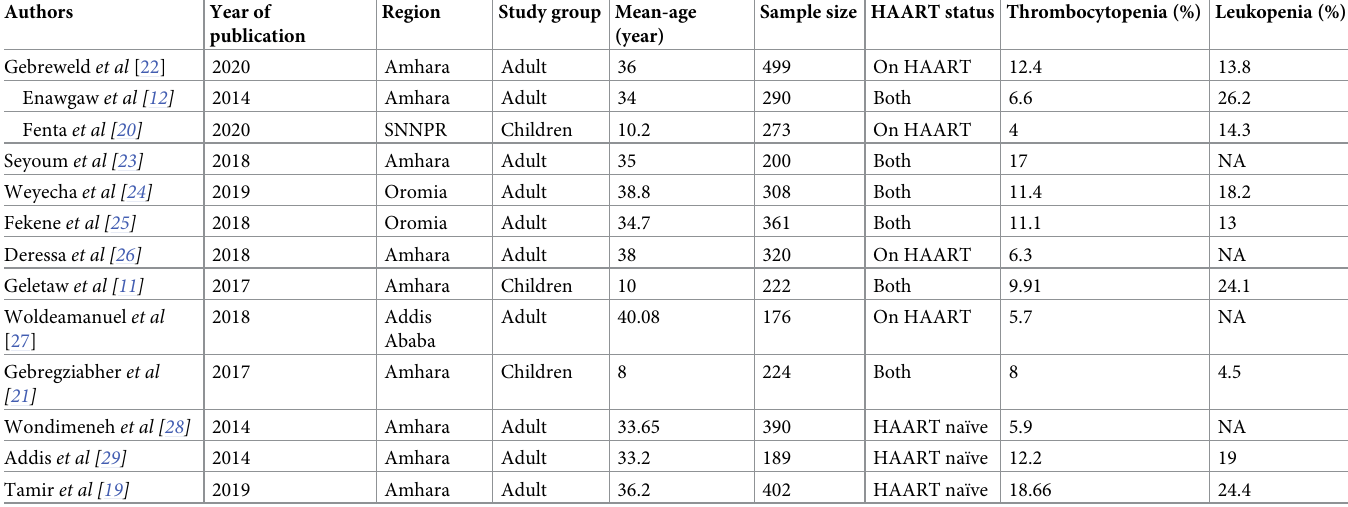
Thrombocytopenia by HAART status. In this systematic review and meta-analysis, ten and nine studies assessed the magnitude of thrombocytopenia in HIV/AIDS patients who are taking HAART and who are HAART na ï ve, respectively. The prevalence of thrombocytopenia among HAART naive participants ranges from 5.9% (95%CI; 3.56–8.24%) to 26% (95% CI;17.4–34.6%) with pooled prevalence of 11.91% (95%CI;8.51–15.31%) (Fig 3). The pooled prevalence was lower in participants taking HAART (5.95%, 95%CI;3.87–8.03%) (Fig 4). In both cases, there were high heterogeneity with I 2 of 84.1% and 79.4%, respectively. Table 1. Characteristics of the included